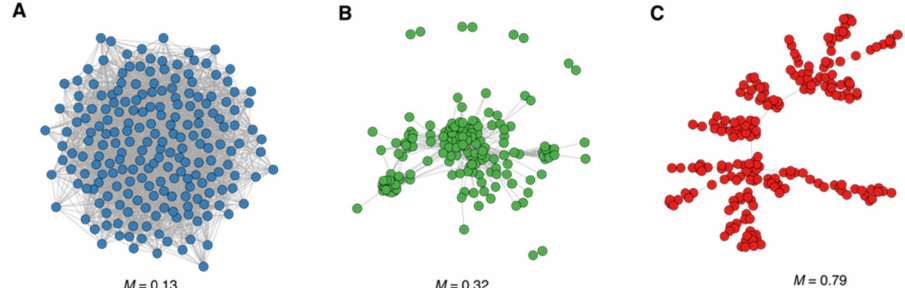
Figure 5. Modularity of the drug similarity network. The modularity ( M ) of the drug similarity network ( A ) is compared with a network model in the low end of the modularity range ( B ) and with a network model in the upper end of the modularity range ( C